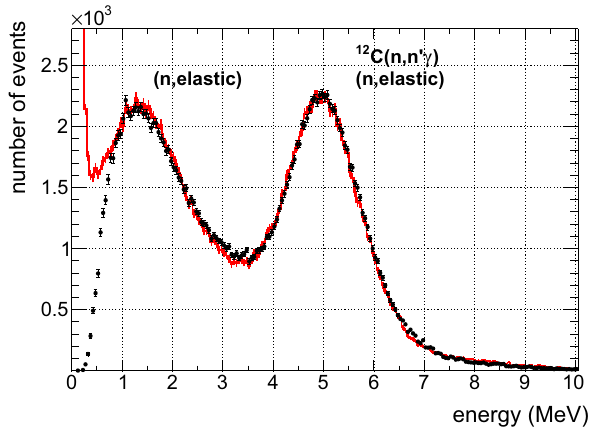
Fig. 4 Energy spectrum of the prompt signals, after background sub- traction (in black), compared with the simulation (in red). The detection threshold is at about 0.8 MeV